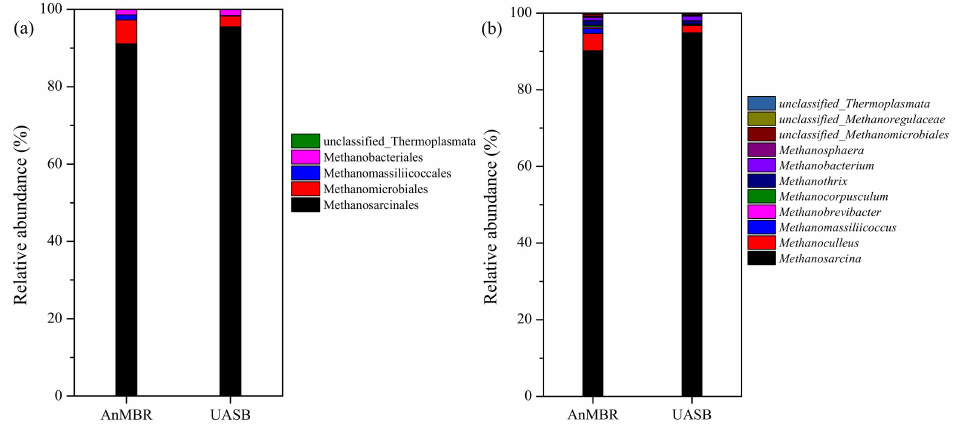
Figure 8. Order ( a ) and genus ( b ) level of archaea in AnMBR and UASB.